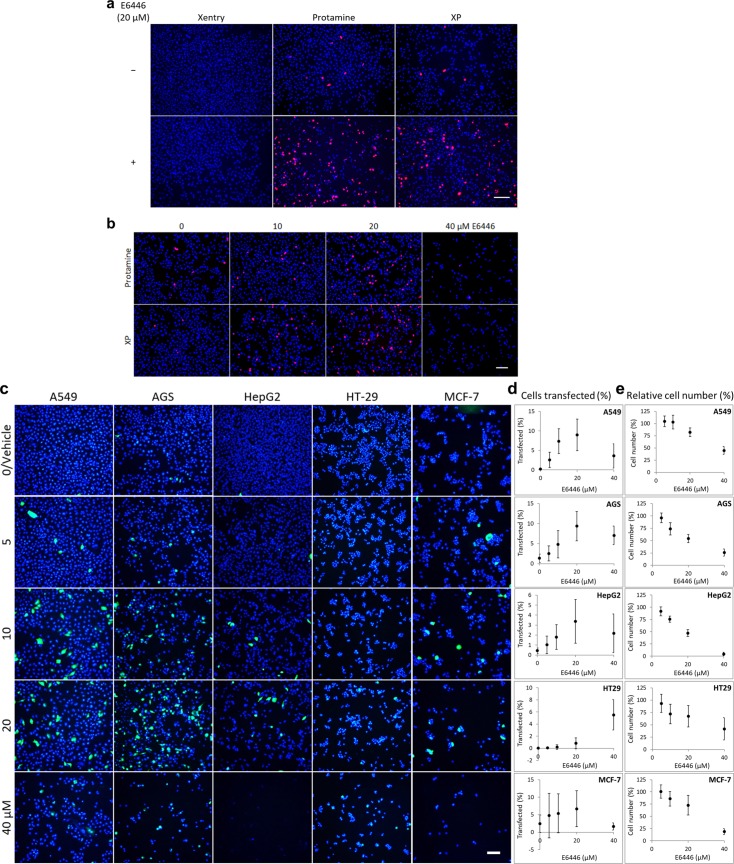
mRNA transfection by protamine-containing CPPs is enhanced by certain concentrations of TLR antagonist E6446.(a) Fluorescence imaging of RFP expression (red) in human gastric cancer (AGS) cells 24 h after treatment with RFP mRNA mixed with Xentry, truncated human protamine, or XP. (b) Fluorescence imaging of RFP expression (red) in AGS cells 24 h after treatment with RFP mRNA mixed with either truncated human protamine or XP. (c, d) Fluorescence imaging and quantification of EGFP expression (green) in human lung (A549), gastric (AGS), liver (HepG2), colon (HT-29), and breast (MCF7) cancer cell lines 24 h after treatment with EGFP mRNA mixed with XP and 0–40 μM E6446. Cell counts following transfection were also quantified (e). Cell nuclei are stained blue with DAPI; scale bars = 100 μm. Data are shown as mean ± 95% confidence interval and are representative of 4+ independent experiments.